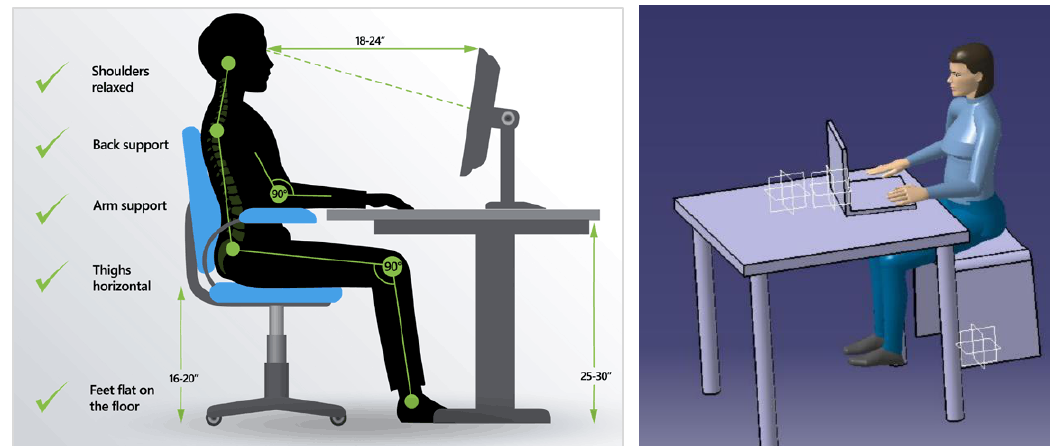
Figure 5. Optimized workspace and body position